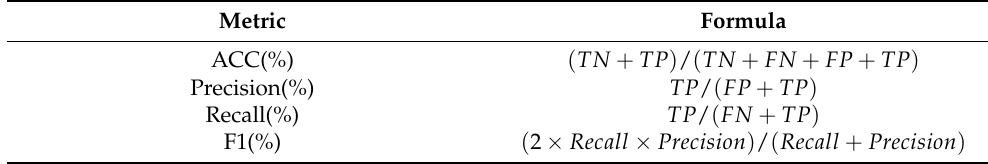
Table 2. List of the predicted performance assessment metrics.